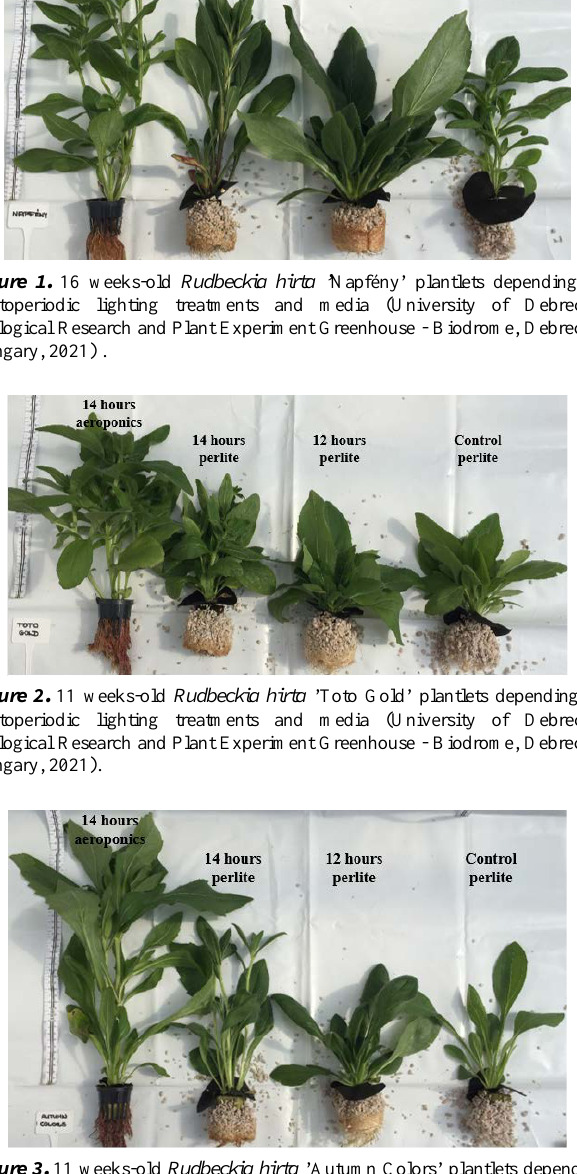
Figure 3. 11 weeks-old Rudbeckia hirta ’Autumn Colors’ plantlets depending on photoperiodic lighting treatments and media (University of Debrecen, Biological Research and Plant Experiment Greenhouse - Biodrome, Debrecen, Hungary, 2021).